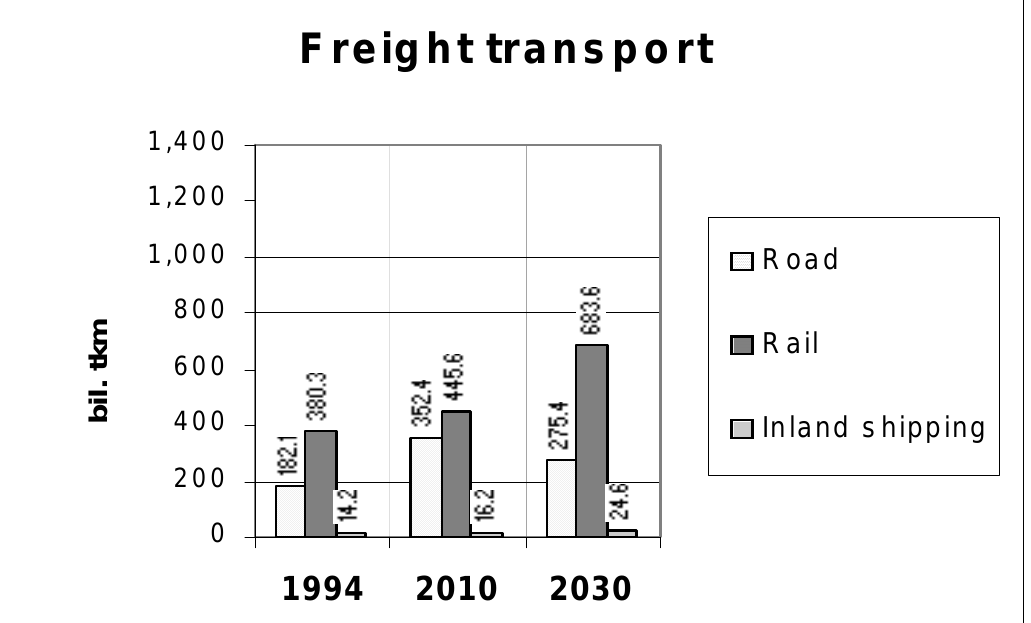
Figure 5 . Modal split for passenger transport under the Environmentally Sustainable Transport scenario (EST3) for the CEI region